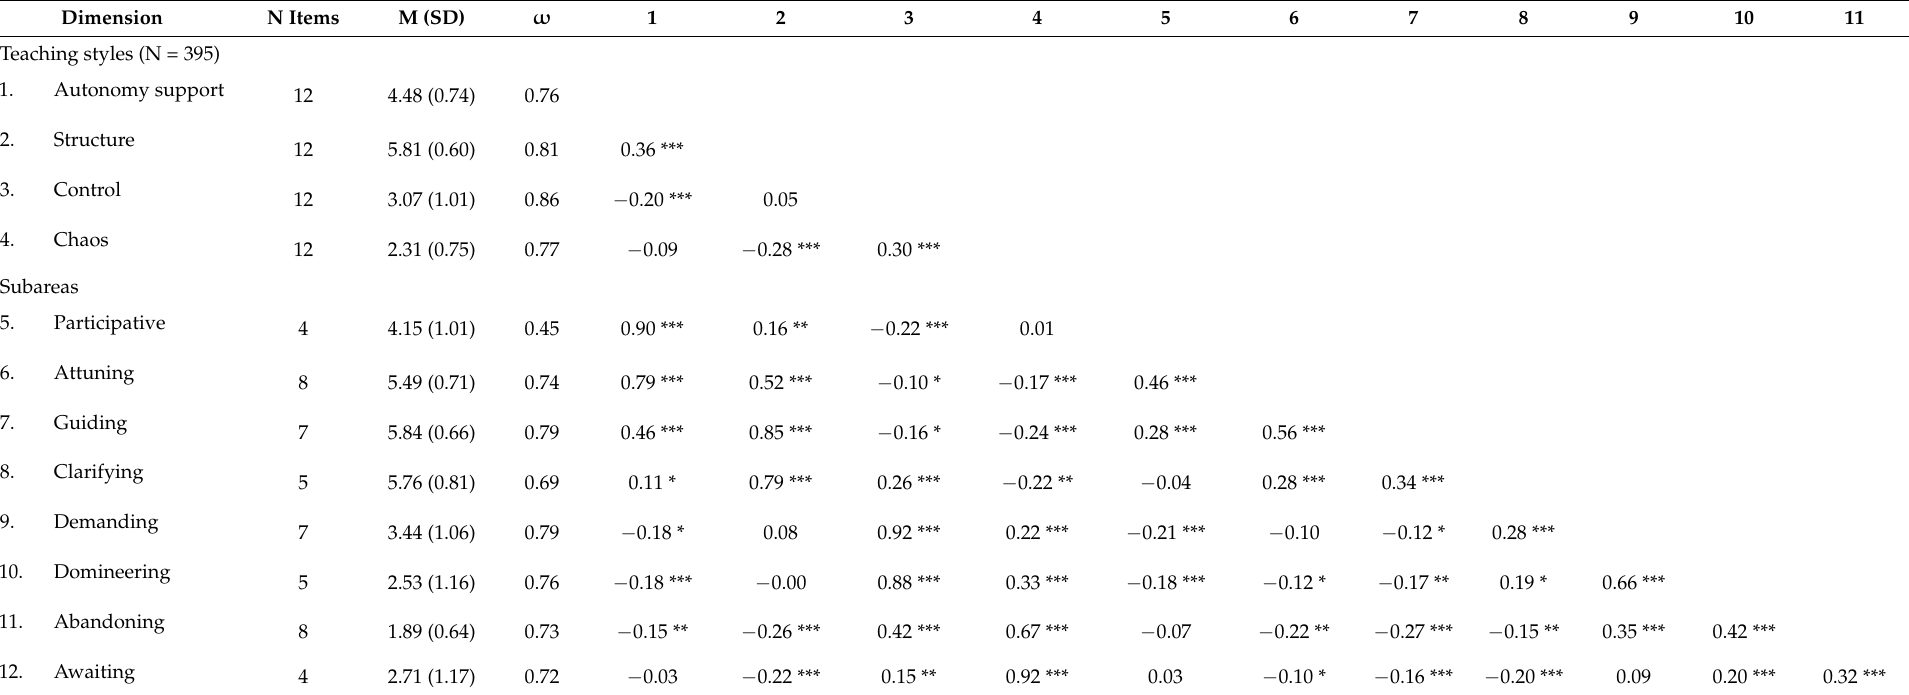
Table 3. Means, Reliabilities, and Correlations Among the Four Teaching Styles and Eight Identified Subareas in Belgium and